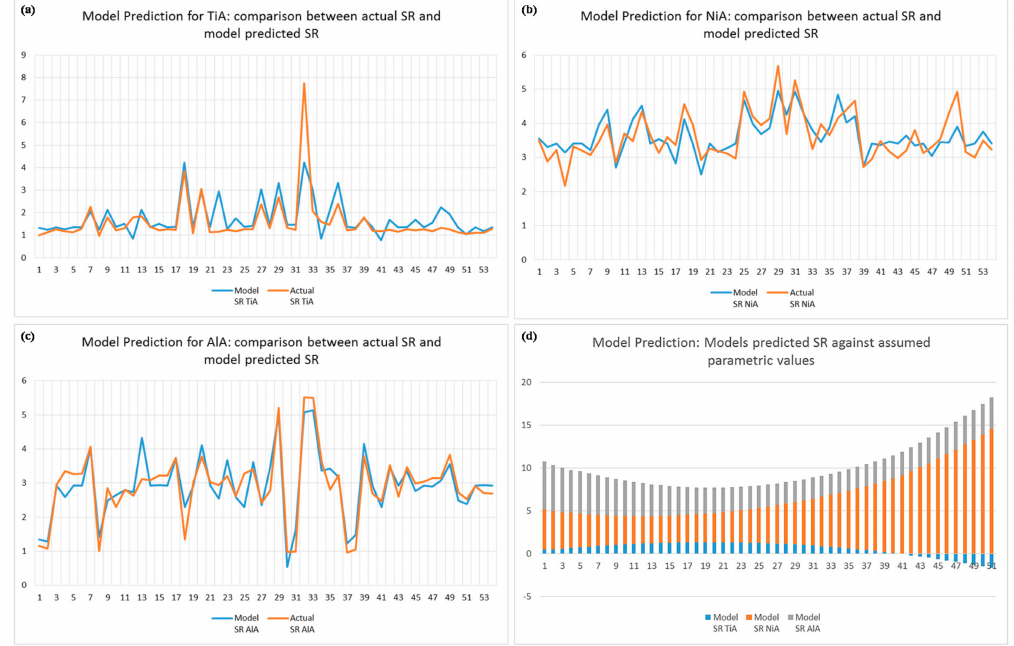
Figure 9. Verification of statistical models. Comparison of model predicted and actual experimental data for: ( a ) titanium alloy, ( b ) nickel alloy, ( c ) aluminum alloy, and ( d ) model predicted roughness using assumed ranges of laser parameters other than the used